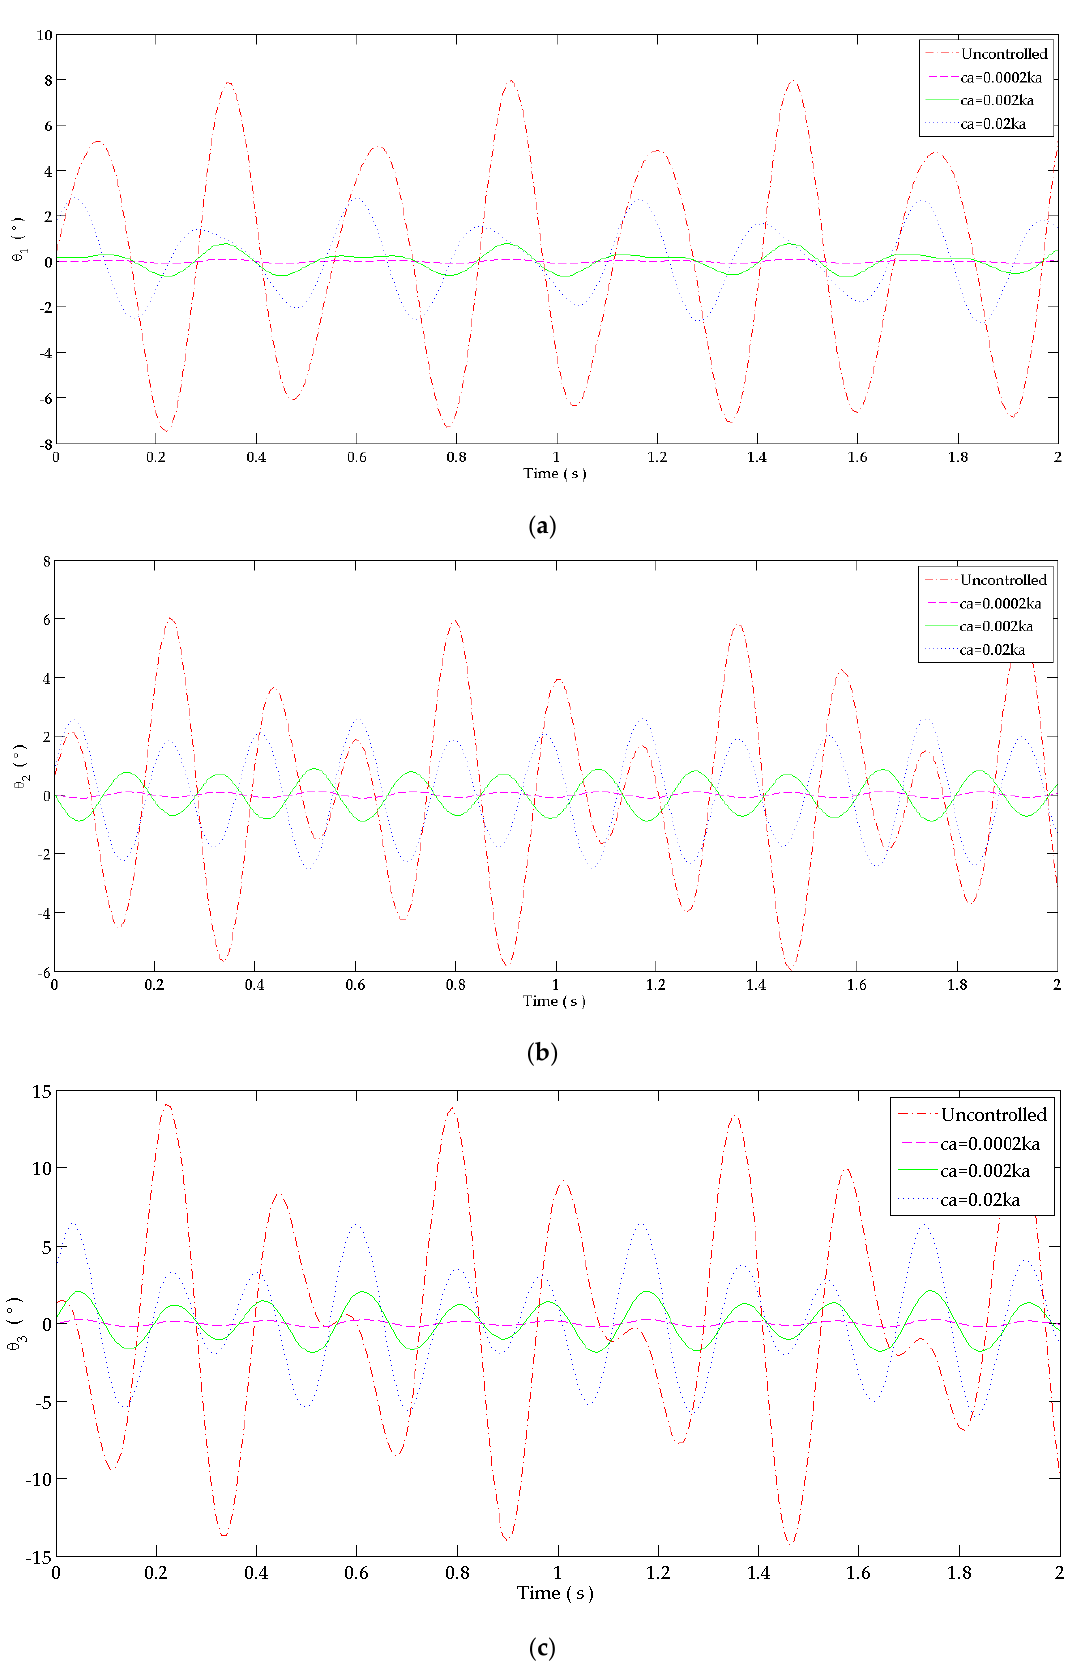
Figure 9. Response in the frequency domain at: ( a ) Shoulder joint; ( b ) Elbow joint; ( c ) Wrist joint. The behavior at each joint is studied when attaching to the forearm due to the ”dual DVA” tuned at wrist joint’s responses. It is compared to the response of the uncontrolled system.